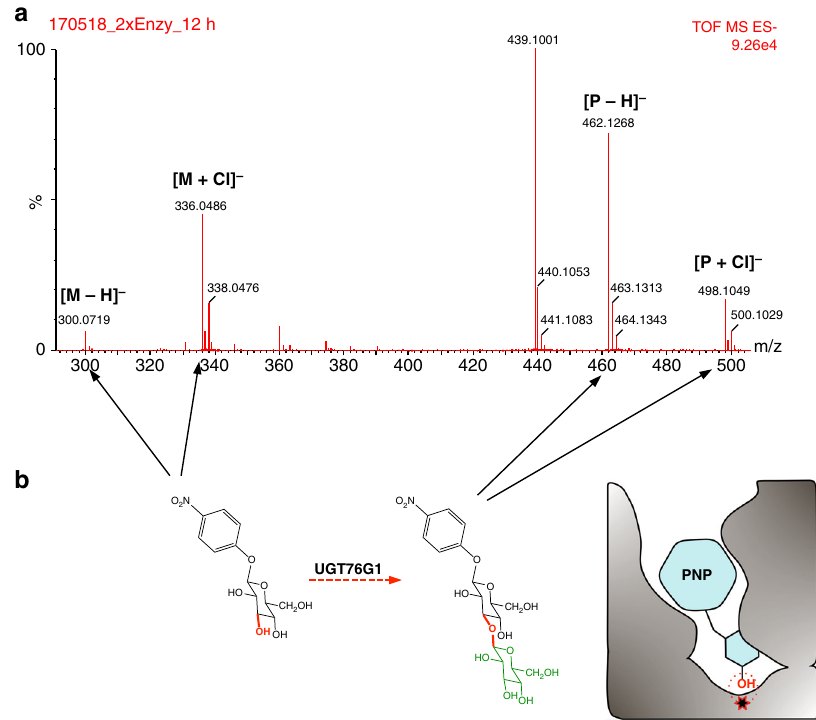
Fig. 7 Replacement of the steviol aglycone ring of the substrate by another hydrophobic group. a Direct MS of the reaction of 4-nitrophenyl β -D- glucopyranoside by UGT76G1. The nitrophenyl ring shows a similar role to give the reactivity to the glycone unit. The reaction of 4-nitrophenyl β - D - glucopyranoside was catalyzed by 0.25 mg ml − 1 UGT76G1 for 12 h. The two main negative ions derived from the substrate (M) and product (P) are labeled. b The slow reaction scheme and the binding mode of 4-nitrophenyl β -D-glucopyranoside by